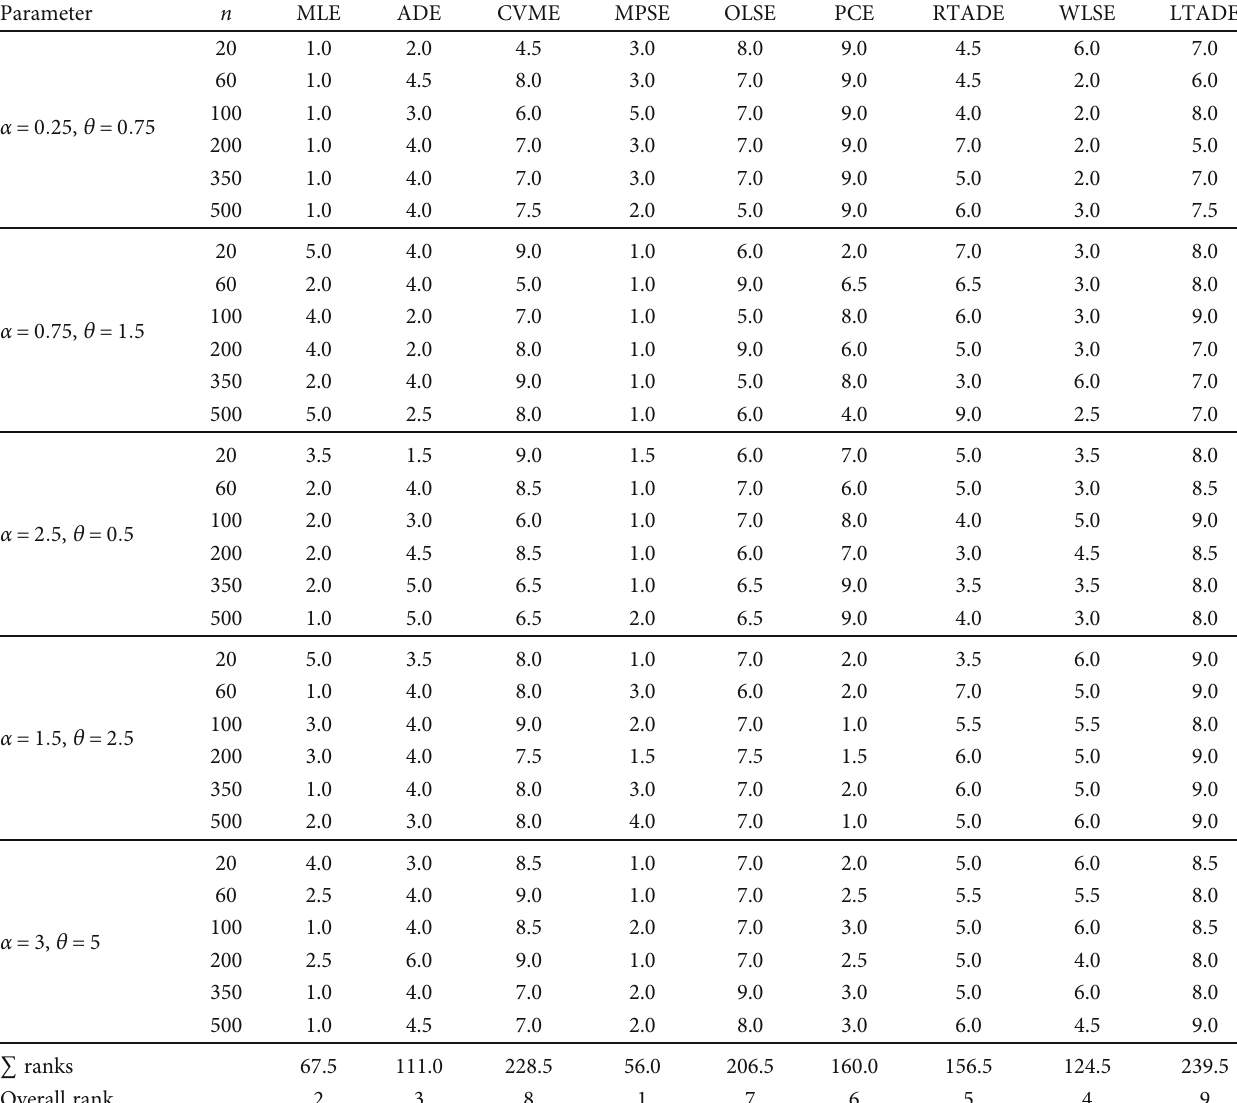
Table 7: Partial and overall ranks of all estimation methods of PXL